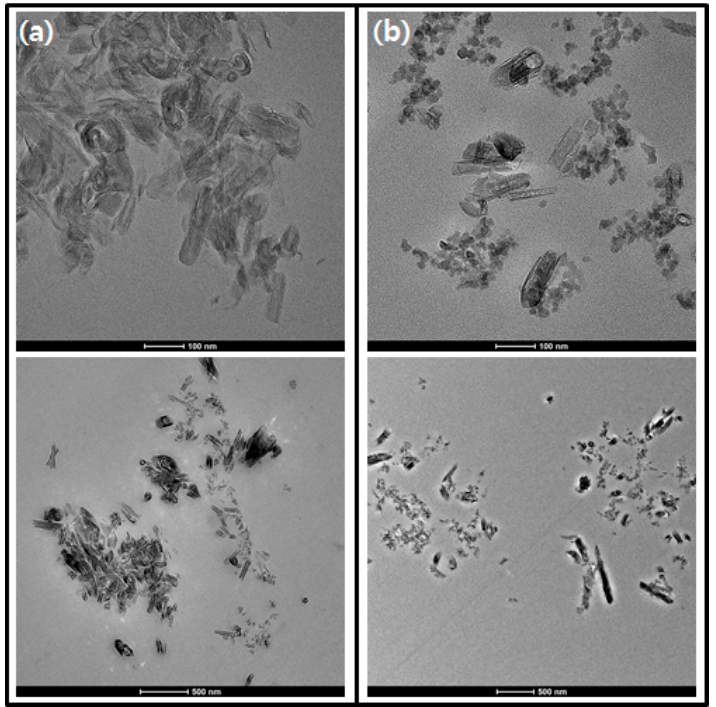
Figure 8. TEM images of epoxy composites with ( a ) HNT and ( b ) Zr/HNT at 10 wt % filler content. The CTE values ( a 1 ) of epoxy composites with different fillers and filler contents are shown in